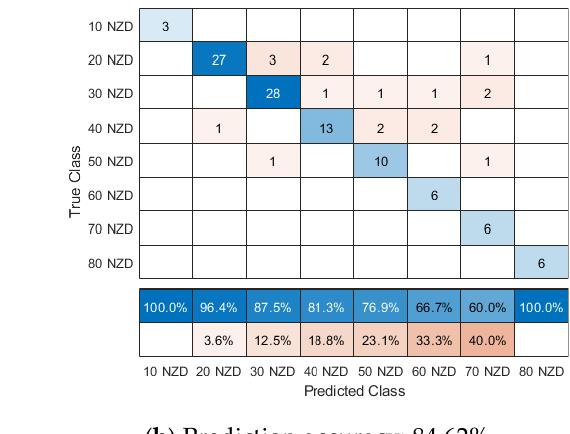
Figure 5. Confusion matrix about the soft sensors using a decision tree and Naive Bayes to predict New Zealand Pinot noir wines’ price points and actual price, respectively. ( a ) has displayed the confusion matrix of soft sensors using decision tree when New Zealand Pinot noir wines’ price are classified into three categorize, namely high price (>60 NZ dollars), middle price (30–60 NZ dollars) and low price (<30 NZ dollars). ( b ) has displayed the confusion matrix of soft sensors using Naive Bayes when New Zealand Pinot noir wines’ prices are classified into 10–80 NZ dollars. When retail price of New Zealand Pinot noir wine has ranged from 5–15 NZ dollars, this wine would be classified as 10 NZ dollars.